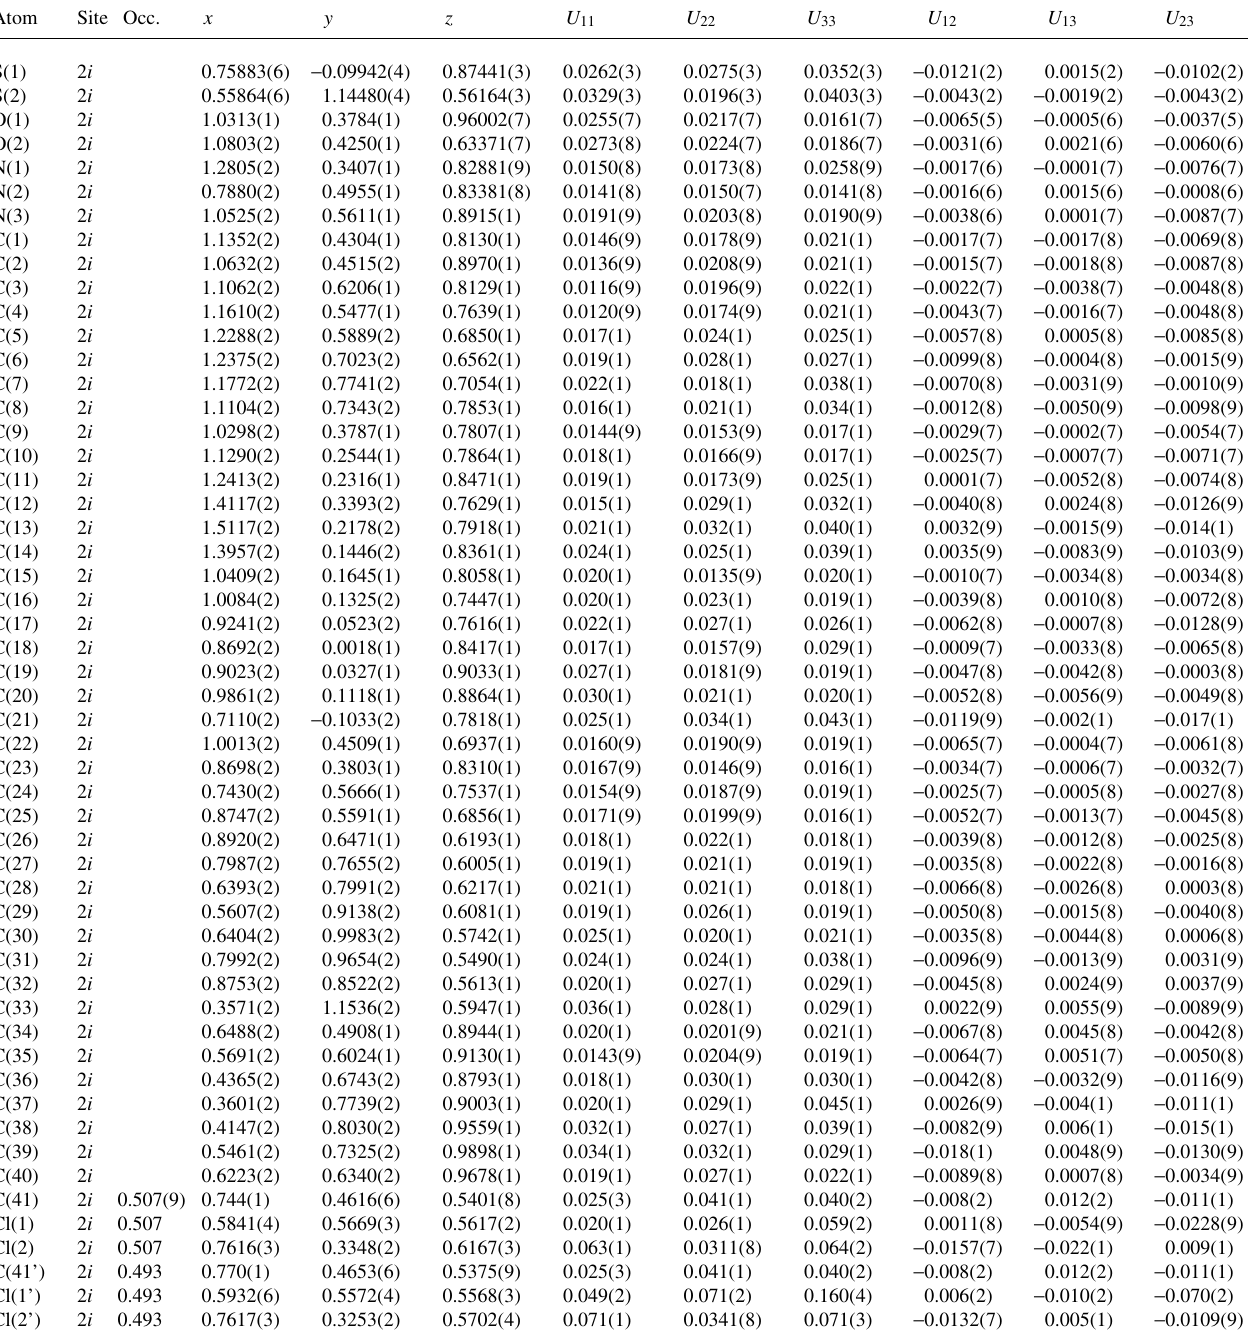
Table 3. Atomic coordinates and displacement parameters (in Å 2 )